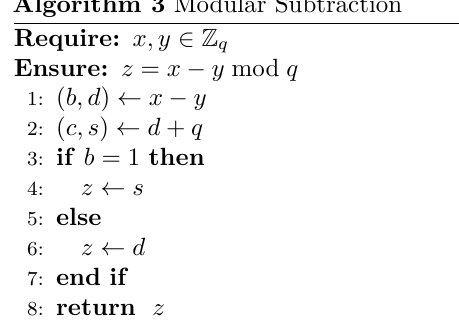
Algorithm 2 Modular Addition Algorithm 3 Modular Subtraction